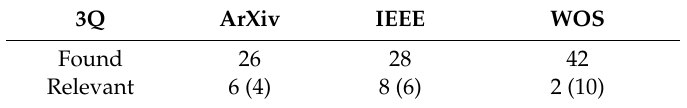
Table 3. Results from the search after “Novel semantic image captioning” search query.